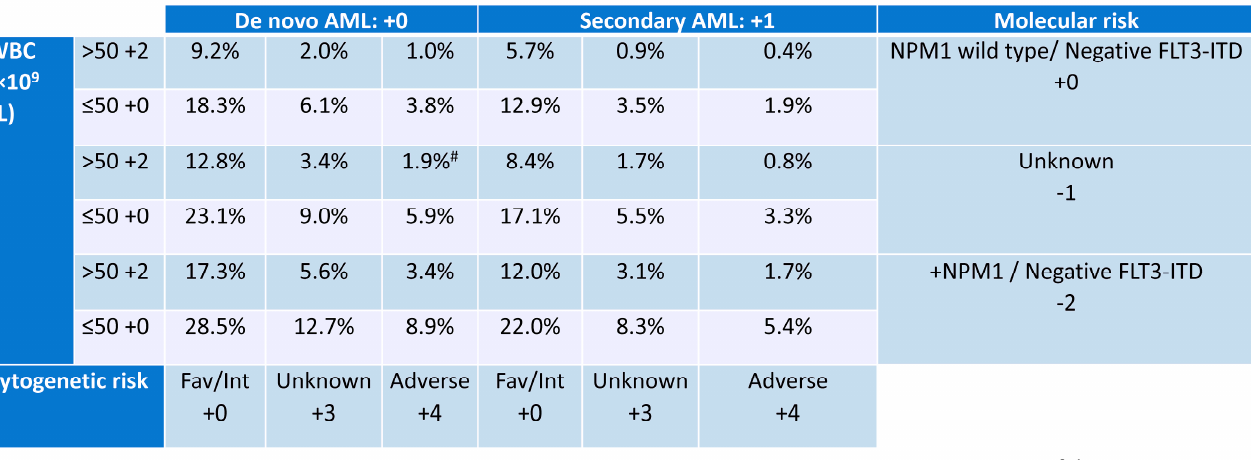
Figure 1. Predicted 5-year overall survival probability using European Risk Score (ESS70+; modi- fied) [45].